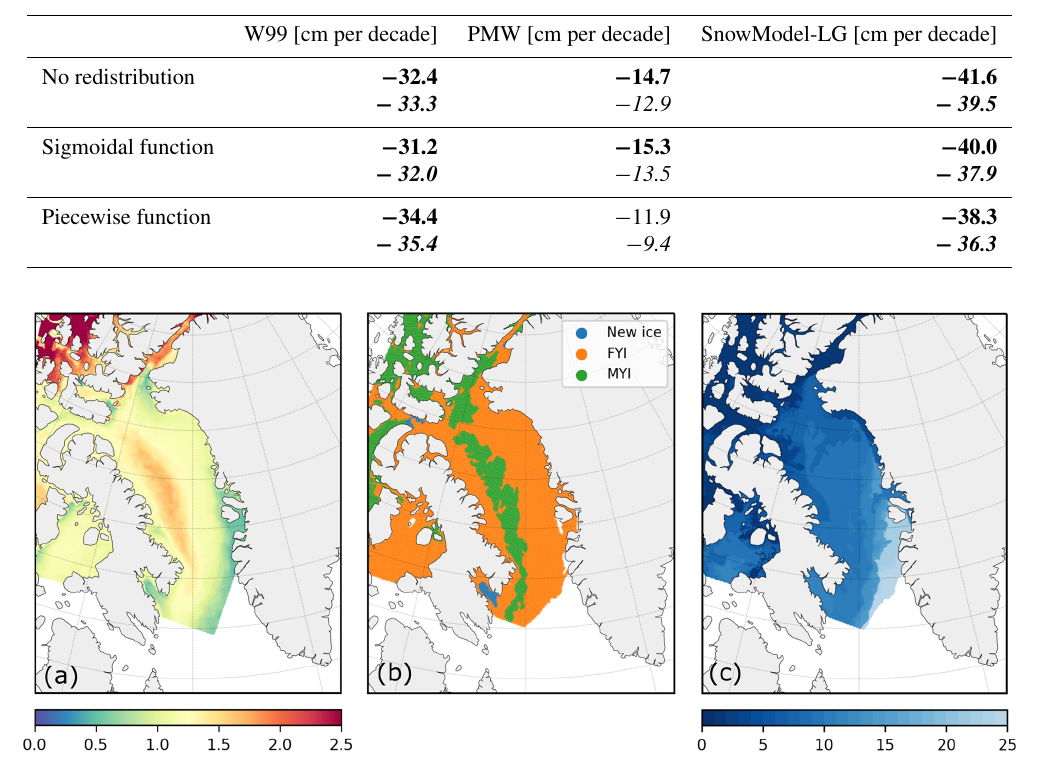
Table 4. Trend in west–east asymmetry for ICESat and CryoSat-2 LARM (2003–2020) for different snow depth products and snow redis- tribution methods. The first values represent the W99 snow density values, and the italic values represent the SnowModel-LG snow density